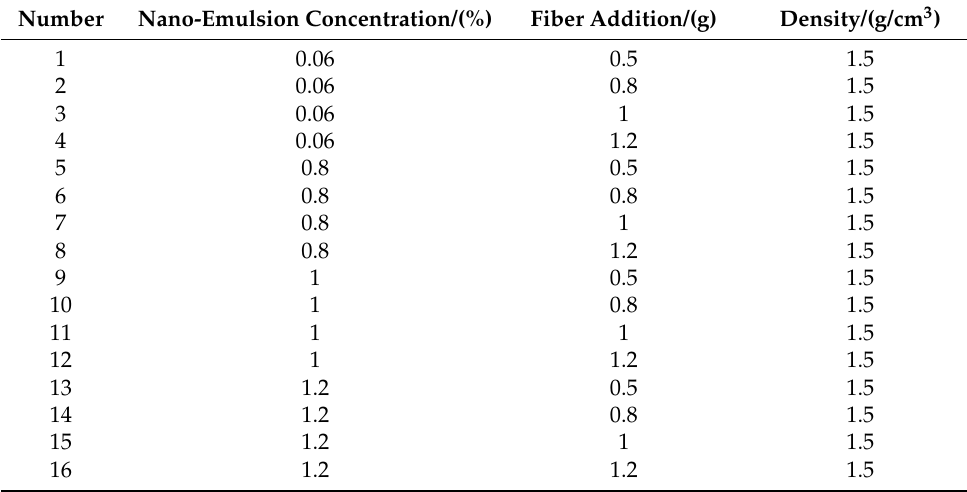
Table 3. Experimental program of nano-cleaning